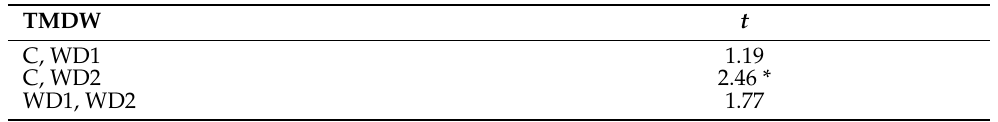
Table 6. Results of PERMANOVA pairwise t -tests (mean dry weight) between treatments; TMDW = total mean dry weight per pot; C = 0% wood distillate; WD1 = 0.2% wood distillate; WD2 = 0.5% wood distillate.